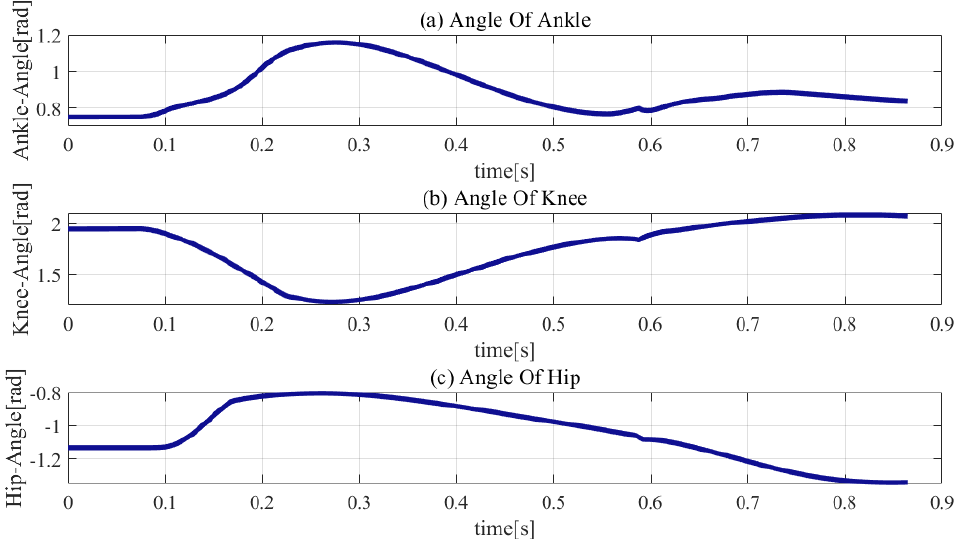
Figure 11. Joint trajectories in simulation.